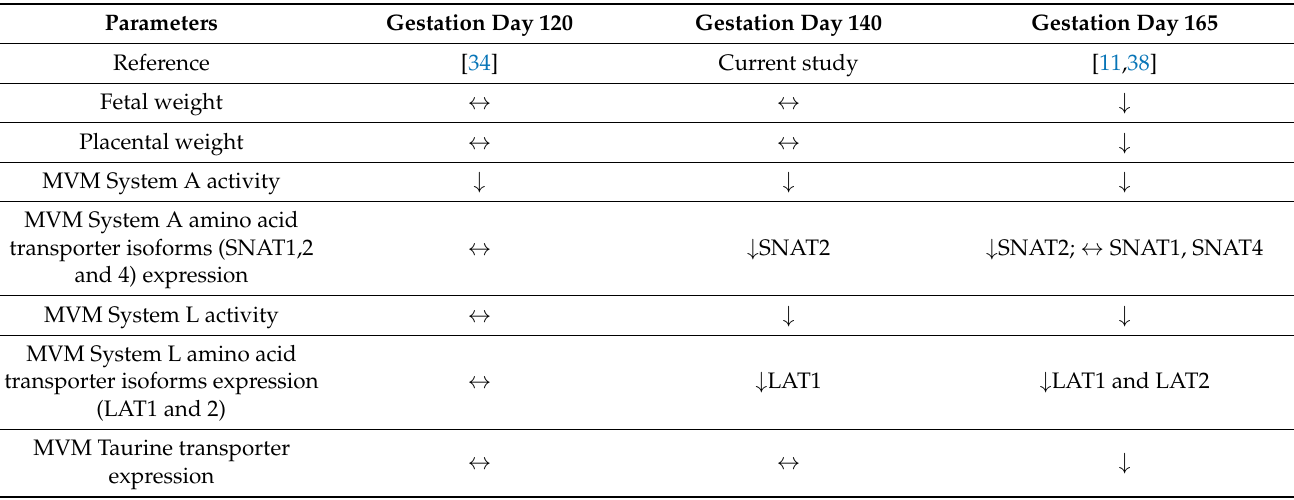
Figure 10. MVM TAUT and GLUT1 protein expression. ( A ) Western blot analysis of amino acid transporter isoforms TAUT and glucose transporter (GLUT1) in MVM isolated from control (C) and MNR (M) baboons at GD 140. ( B ) The histogram shows protein expression data of MVM TAUT and GLUT1. An equal amount of protein loading was performed. After the normalization of MVM TAUT and GLUT1 expression to loading control ( β -actin), the average density of the control sample band was designated an arbitrary value of 1. Values are represented as Medians ± IQR. n = 9/each group. KS normality test p -value: MVM TAUT (Control, p > 0.10; MNR, p > 0.10; passed normality); MVM GLUT1 (Control, p = 0.04, not passed normality; MNR, p > 0.10; passed normality). Table 2. Comparison of significant changes in the fetal and placental weights, MVM and BM system A/L amino acid transport activity and isoform expression, maternal, fetal amino acid concentration, and in vivo transplacental amnio acid transport activity in MNR baboons as compared to control at different gestation